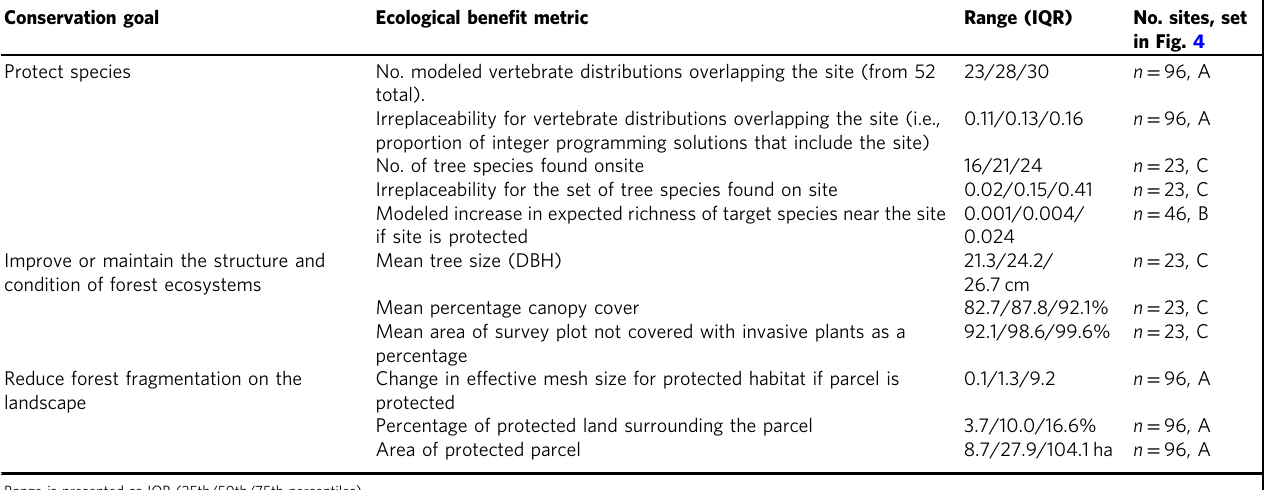
Table 2 Choice of conservation goals and metrics to estimate progress towards these goals Conservation goal Ecological bene fi t metric Protect